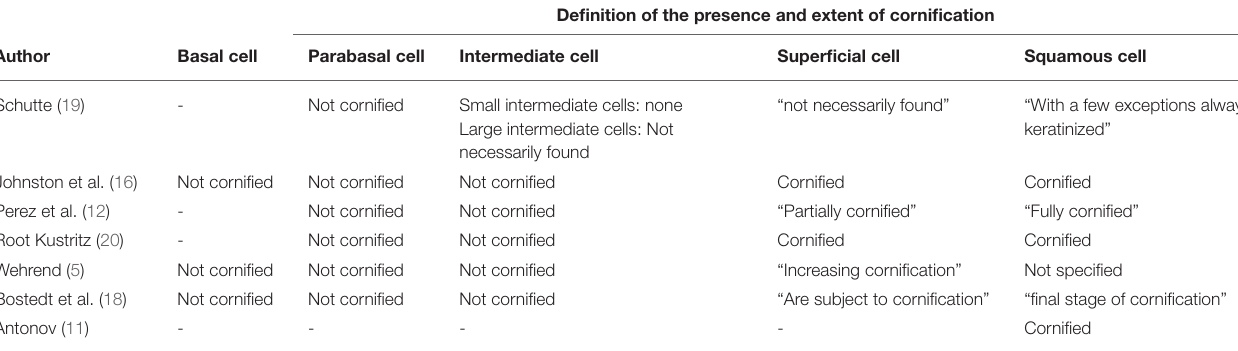
TABLE 2 | Presence and extent of cornification of different types of vaginal cells according to different